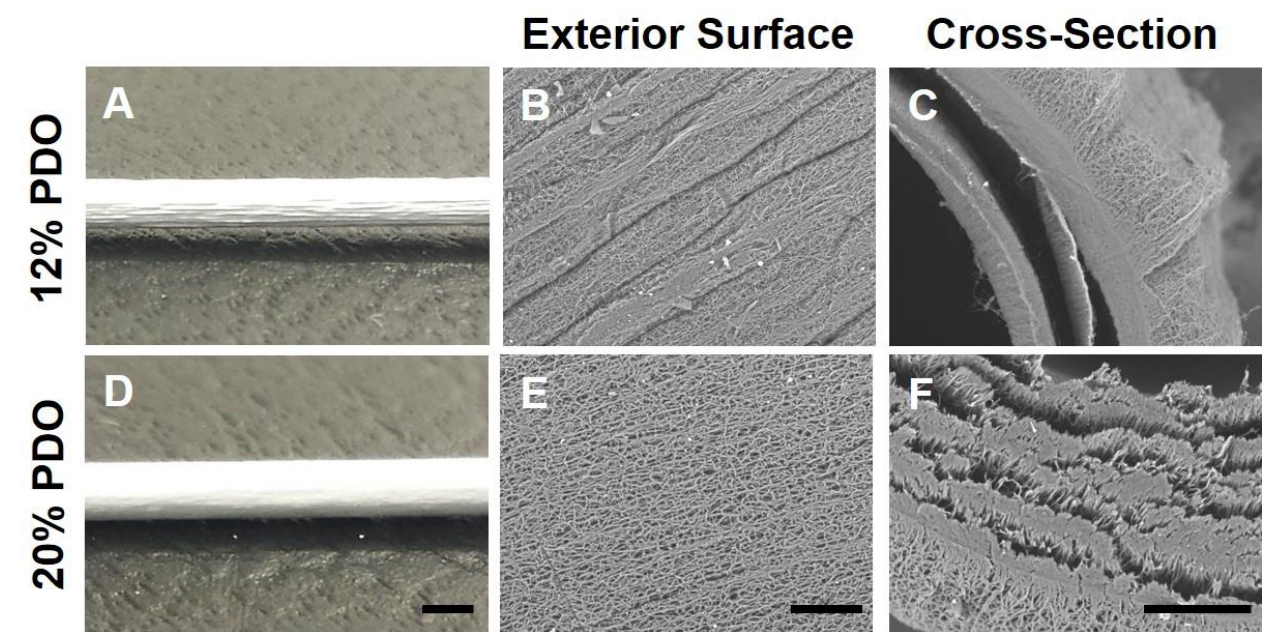
Figure 2. Characterization of electrospun microfibrous PDO vascular grafts. Gross structure ( A , D , scale bar = 1 mm) and SEM images of microstructure of exterior ( B , E , scale bar = 100 μm) and cross-section ( C , F , scale bar = 100 μm) surface of PDO vascular grafts electrospun at 12% and 20% by weight.